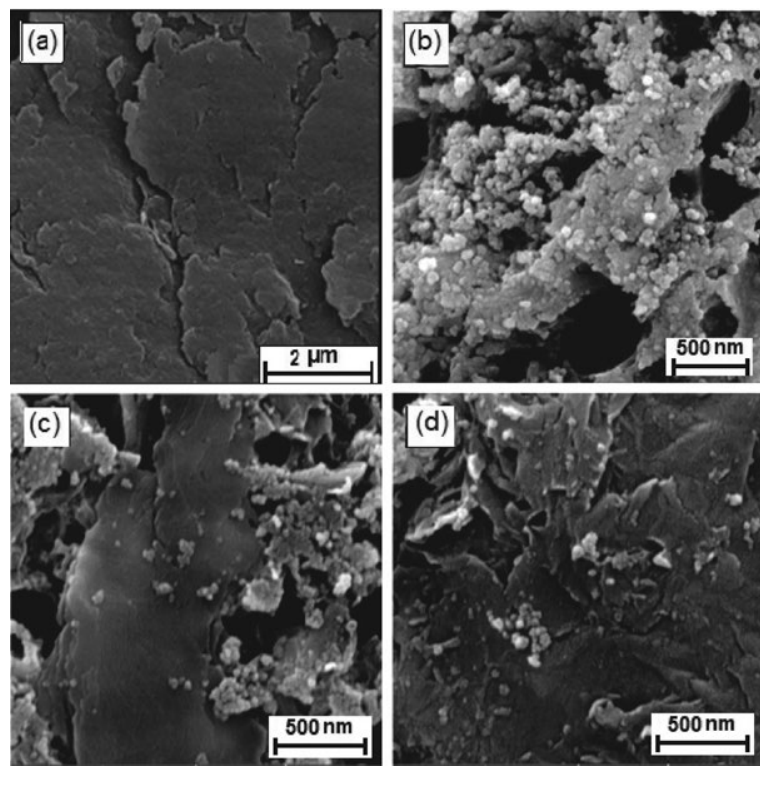
Figure 4. SEM images of (a) GO, (b) Co